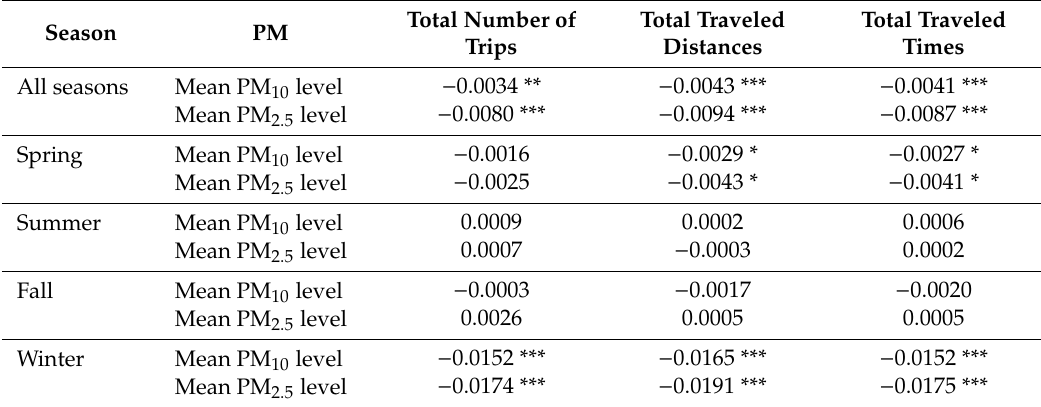
Table 13. Summary of regression coe ffi cients of mean PM 10 and PM 2.5